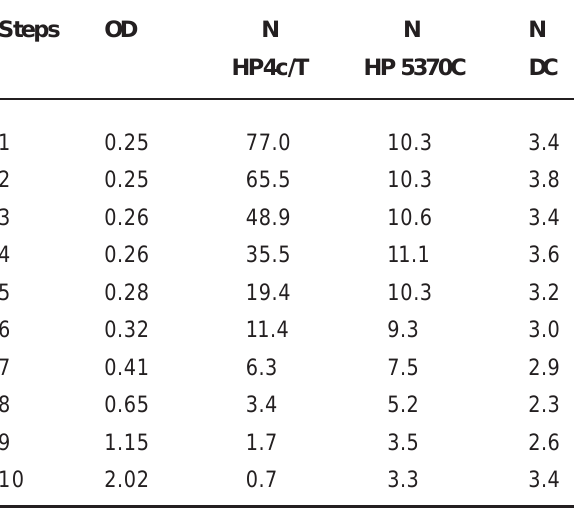
TABLE 2- Results of N obtained for the HP 4c/T, HP 5370C scanners and digital camera in relation to steps and OD (optical